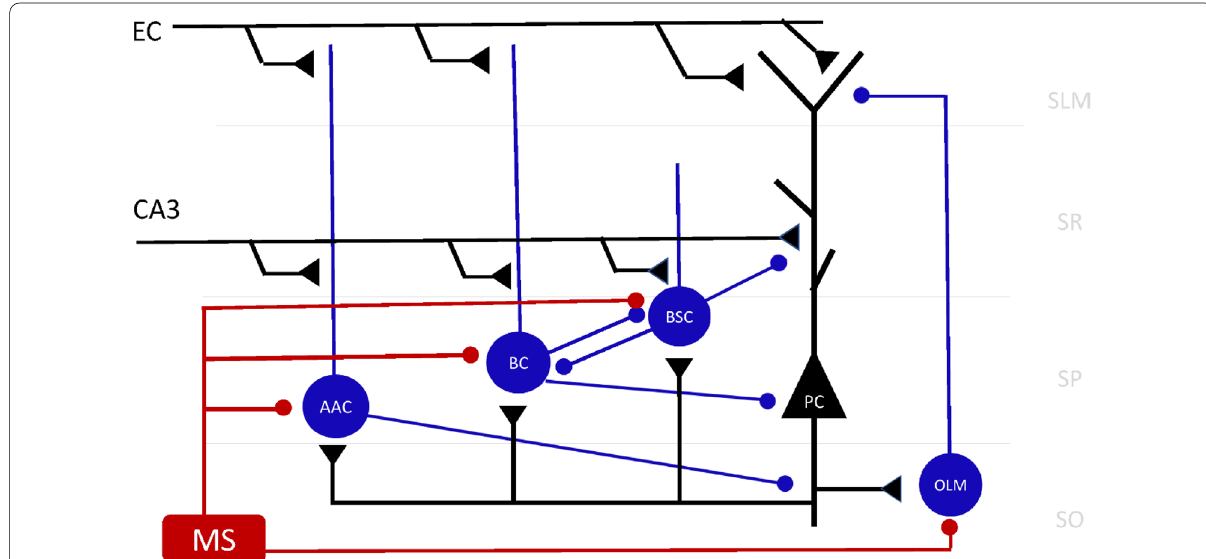
Fig. 1 Hippocampal CA1 microcircuit showing major cell types and their connectivity. SLM: Stratum lacunosum-moleculare; SR: stratum radiatum; SP Stratum pyramidale; SO: stratum oriens; PC: pyramidal cell; AAC: axo-axonic cell; BC: basket cell; BSC: bistratified cell; CA3: CA3 Schaffer collateral input; MS: medial septum. Black lines: excitatory input; blue lines: inhibitory input; maroon lines: MS inhibitory